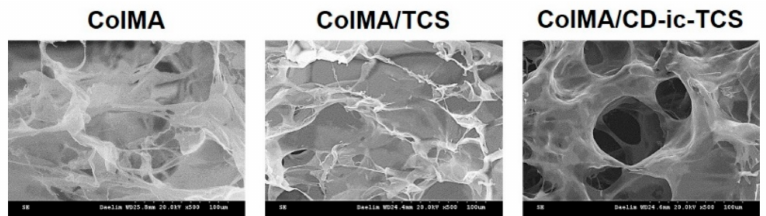
Figure 4. Morphologies of ColMA, ColMA/TCS, or ColMA/CD-ic-TCS observed by SEM at × 500. ColMA—methacrylated collagen; ColMA/TCS—triclosan (TCS) incorporated ColMA; ColMA/CD- ic-TCS—HP- β -CD/TCS complex incorporated